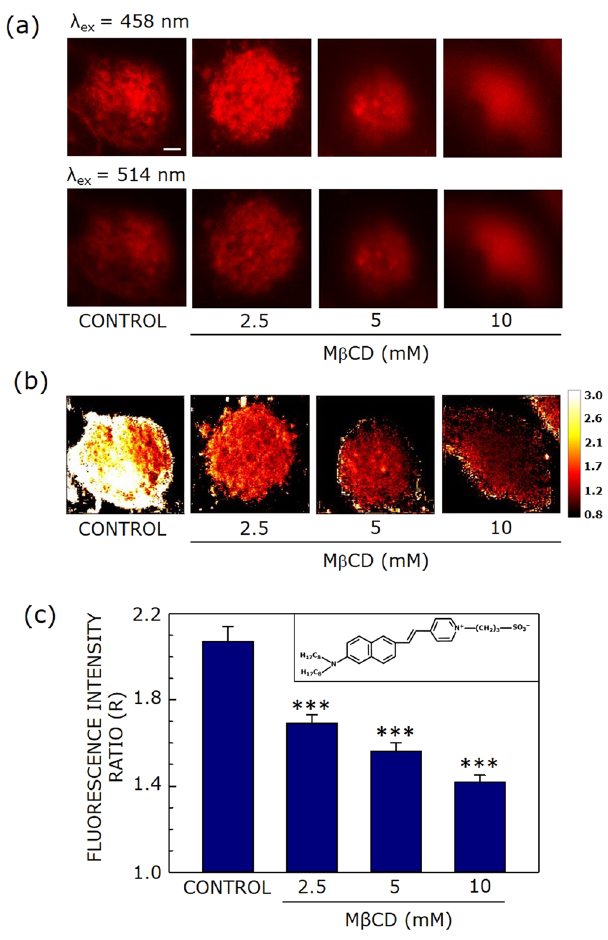
Figure 2. Effect of acute cholesterol depletion on membrane dipole potential. ( a ) Representative confocal micrographs of CHO-K1 cells labeled with di-8-ANEPPS ( λ ex = 458 nm (upper panel), and λ ex = 514 nm (lower panel), the emission band pass being 650–710 nm in both cases) with increasing concentrations of M β CD. Fluorescence intensity of images was corrected for laser power at two different excitation wavelengths (458 and 514 nm). ( b ) The corresponding fluorescence intensity ratio (R) map (color coded in a scale of 0.8–3) under these conditions. R is defined as the ratio of fluorescence intensities at an excitation wavelength of 458 nm to that at 514 nm (emission band pass at 650–710 nm in both cases) and was calculated using ImageJ (NIH, Bethesda, MD). ( c ) Effect of increasing concentration of M β CD on the R value (means ± S.E.), averaged over at least fifteen independent measurements ( *** corresponds to significant ( p < 0.001) difference in R). The inset shows the chemical structure of di-8-ANEPPS. The scale bar indicates 10 μ m. See Methods for more